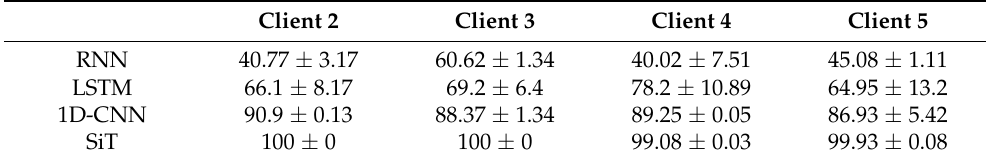
Table 5. Performance comparison of different networks.